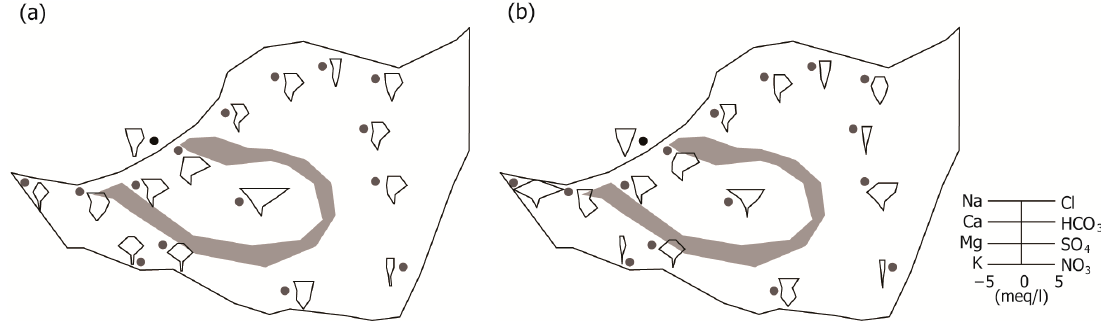
Figure 9. Stiff diagram plot showing chemical characteristics of river water (black dot) and groundwater (gray dots) ( a ) when the river level was 3.5 m (December 2016) and ( b ) 1.5 m (November 2017).